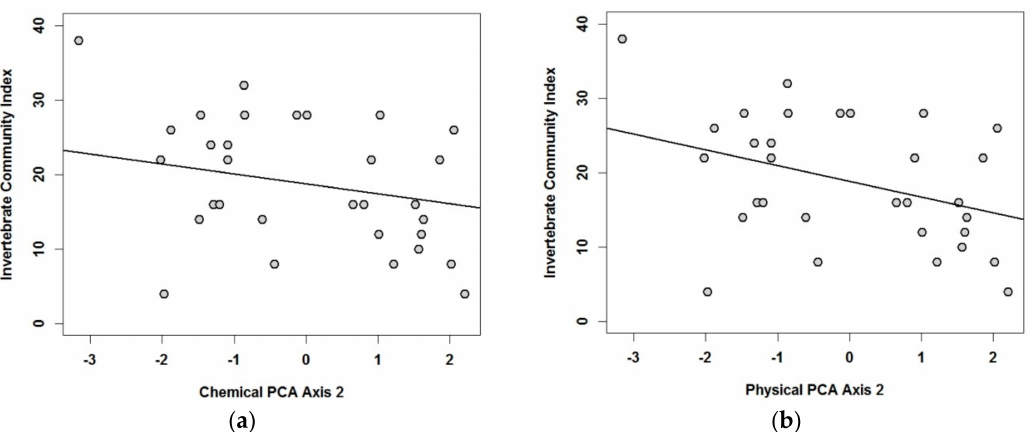
Figure 2. Relationship of Invertebrate Community Index scores with the site scores of second chemical principal components analysis axis (PCA Axis 2) ( a ) and the site scores of second physical principal components analysis axis (PCA Axis 2) ( b ) in eight agricultural headwater streams in Indiana, Michigan, and Ohio, 2017 to 2018. The straight line in 2a is the predicted relationship based on the equation y = 18.747 + 0.713 (chemical PCA axis 1) + − 1.325 (chemical PCA axis 2) + − 0.327 (chemical PCA axis 3) using a range of values for the chemical PCA axis 2 and values of the chemical PCA axes 1 and 3 as 0. The straight line in 2b is the predicted relationship based on the equation y = 18.813 + − 0.009 (physical PCA axis 1) + − 2.108 (physical PCA axis 2) using a range of values for physical PCA axis 2 and values of physical PCA axis 1 as